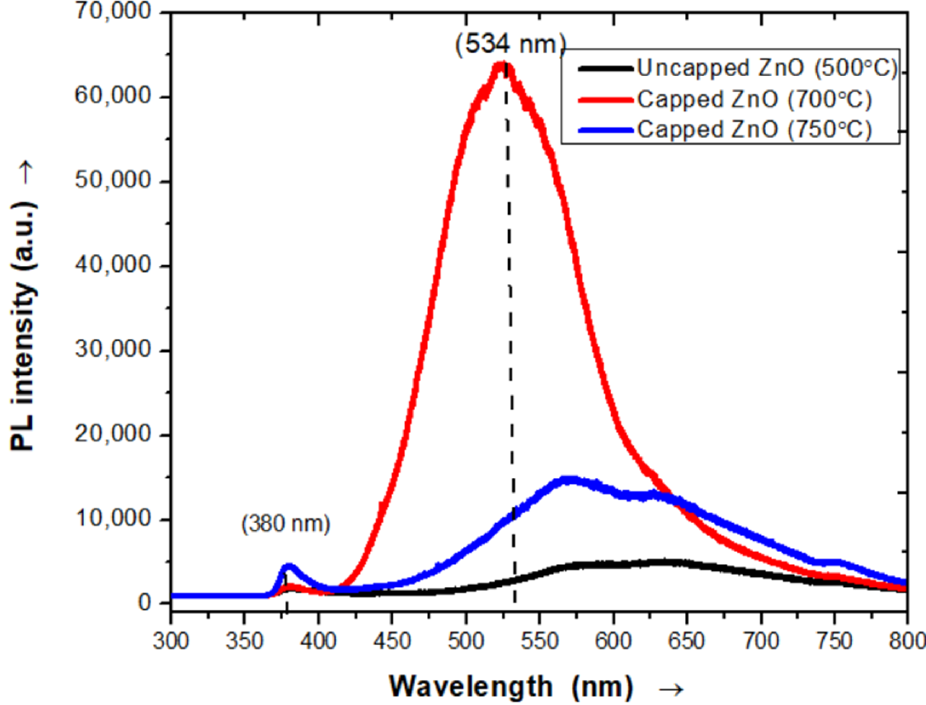
Figure 5. Photoluminescence spectra of prepared pure and capped ZnO nanopowder with differ- ent temperatures.